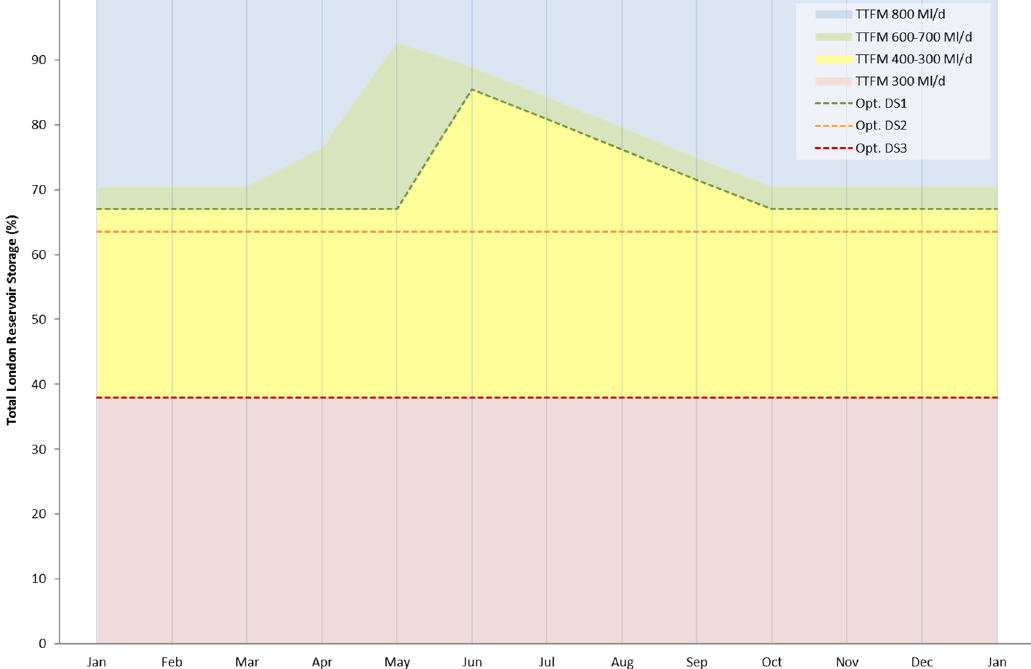
Figure 3. The simplest solution obtained for the LTCD which results in DO of 2144 Ml/day.